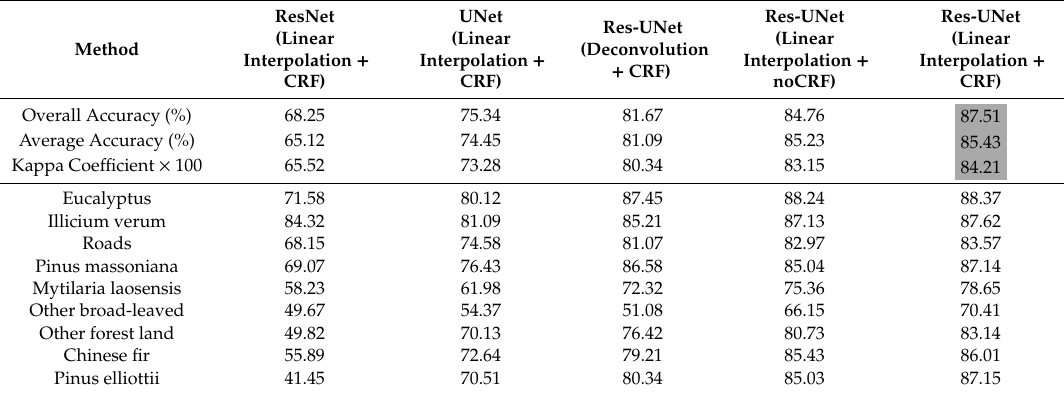
Table 4. Classification accuracy of tree species with di ff erent classification methods.